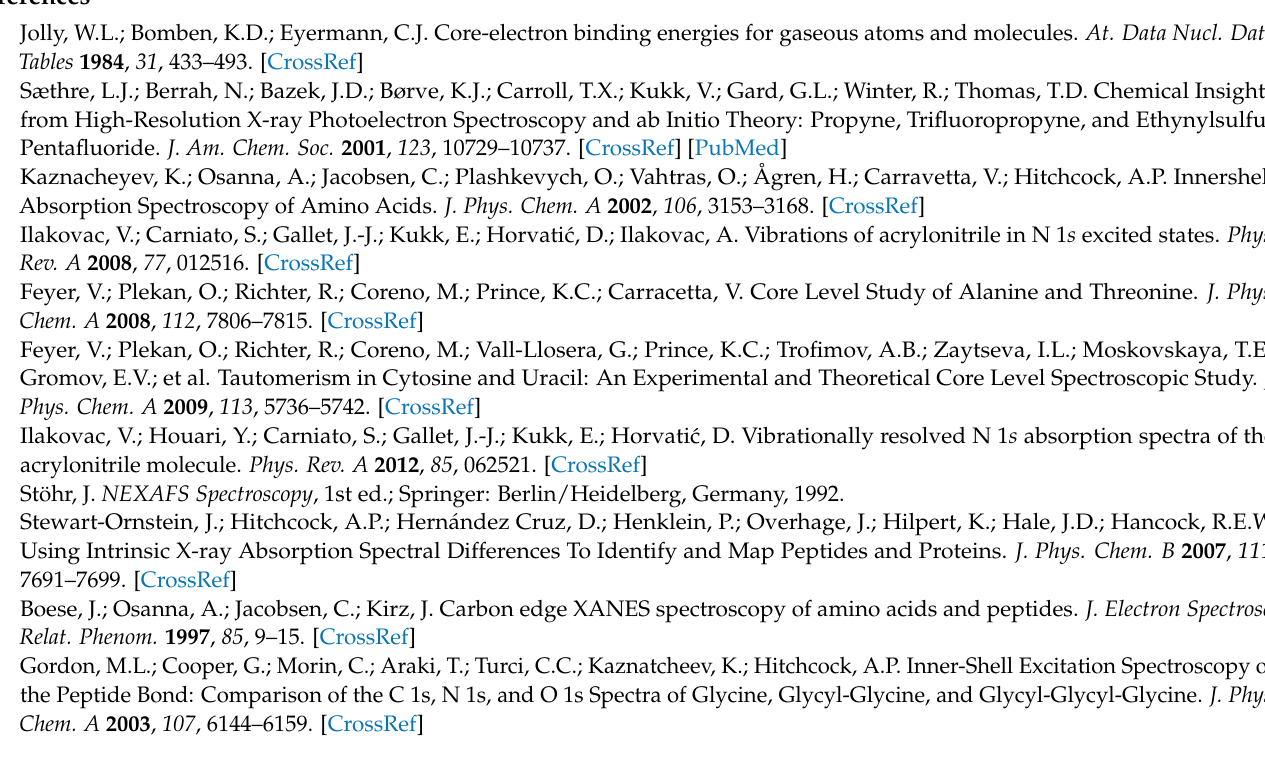
Table S6 showing the relative discrepancies of the IMOM/ELMO 1s core-ionization energies for the carbonyl carbon of 2-decanone with respect to the reference fully IMOM values, for different sizes of the QM region adopted in the QM/ELMO calculations (results for the B3LYP functional). Citations: